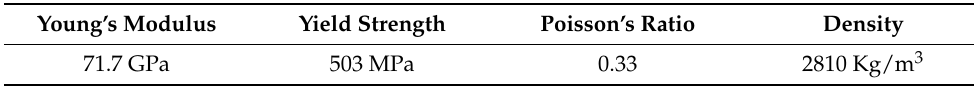
Table 3. Physical and mechanical parameters of Al7075 material.